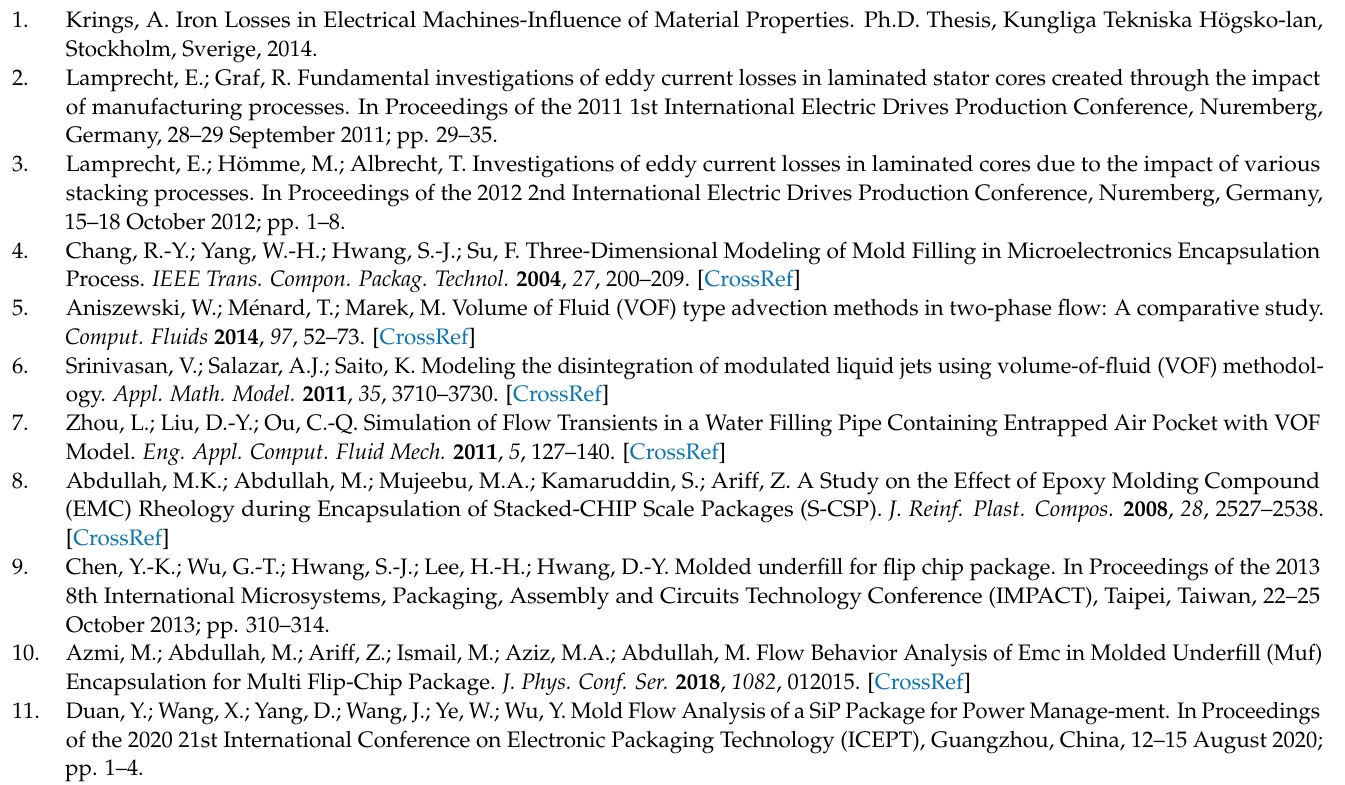
Figure A5. The flow rate is 0.05 cm 3 /s. ( a ) Filling 10%; ( b ) Filling 30%; ( c ) Filling 50%; ( d ) Filling Figure B4. The flow rate is 0.05 cm 3 /sec. ( a ) Filling 10%; ( b ) Filling 30%; ( c ) Filling 50%; ( d ) Filling 331 70%. 332